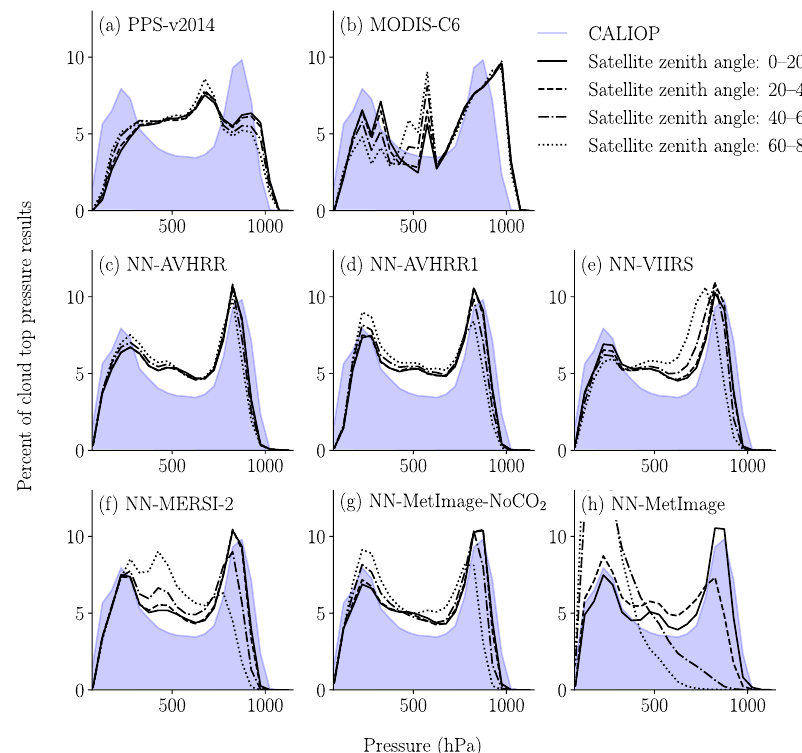
Figure 4. Retrieved pressure dependence on satellite zenith angle. CALIOP pressure distribution is shown in light blue. The percent of cloud top pressure results are calculated in 50hPa bins. The final validation dataset is used (see Table 1).